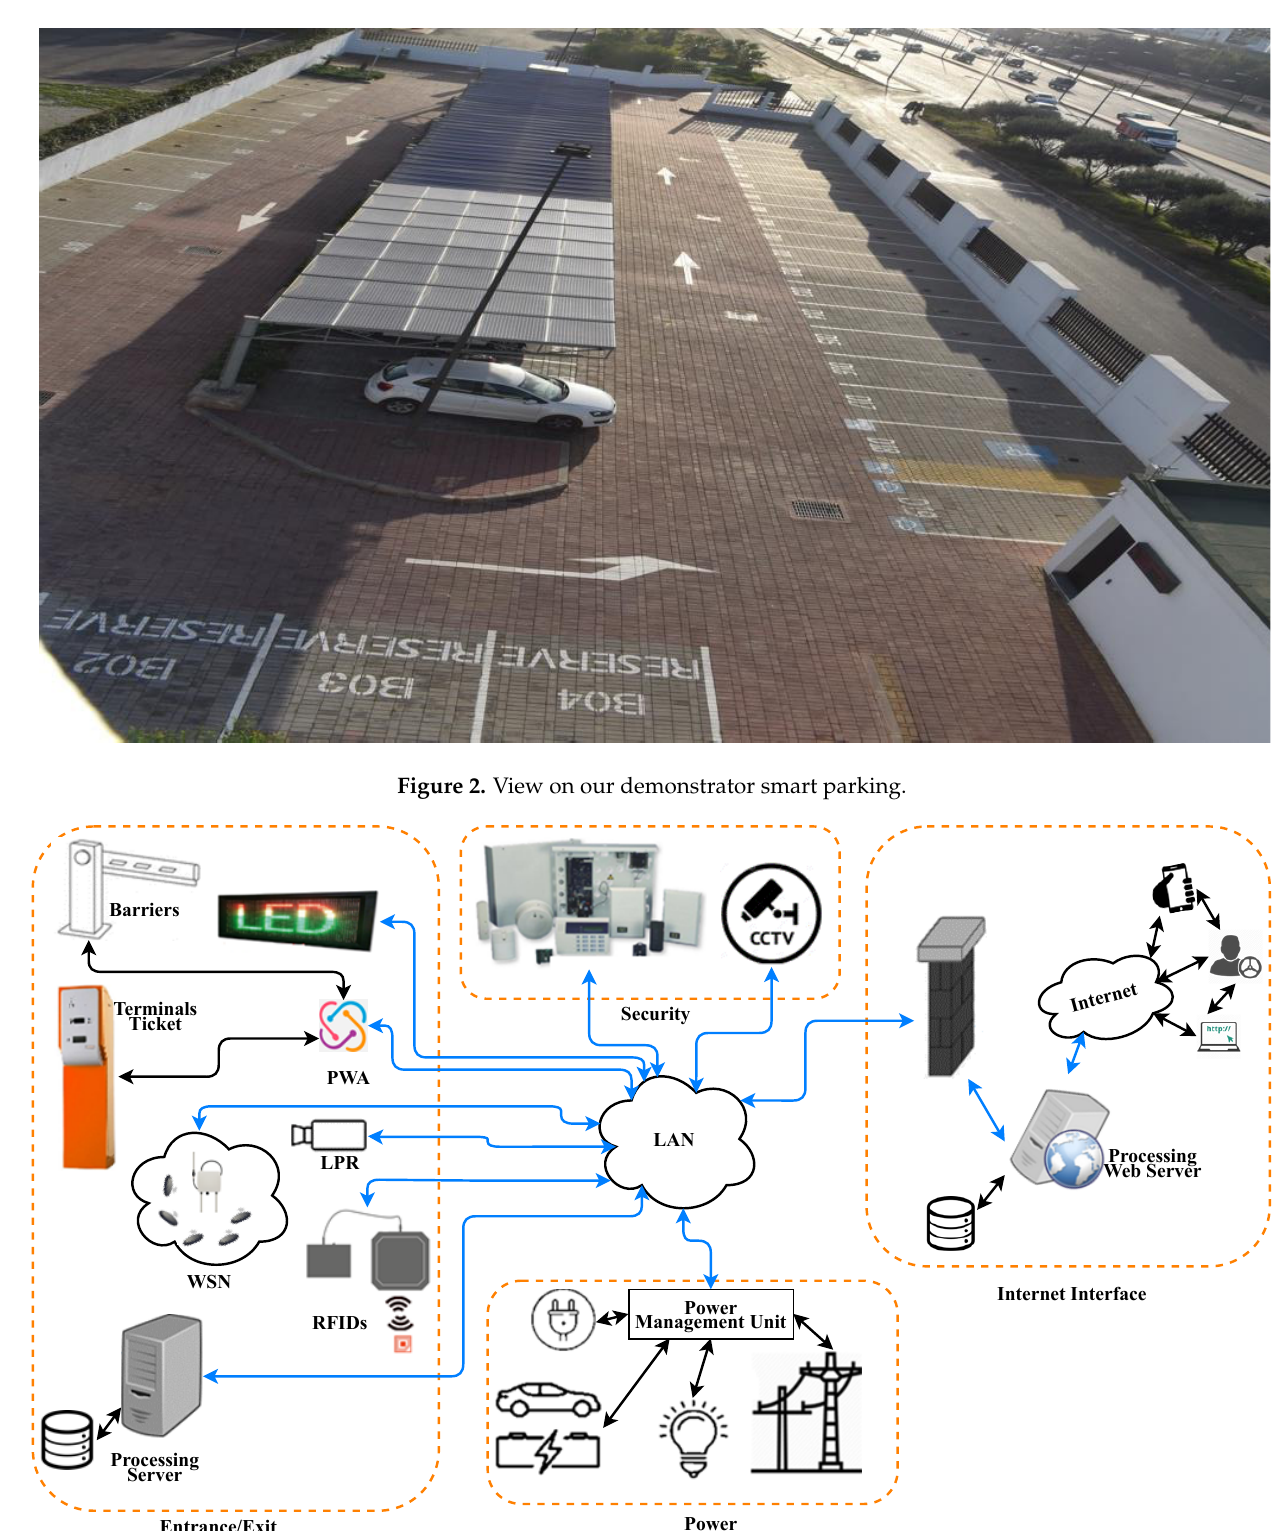
Figure 3. Smart Parking Demonstrator four modules